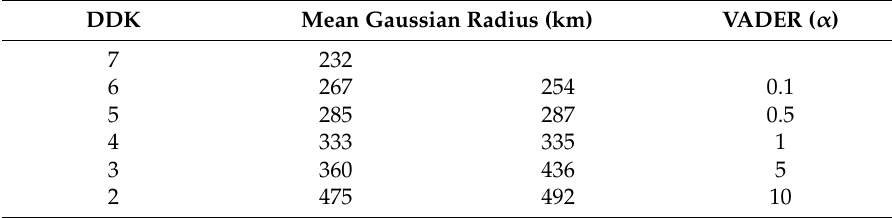
Table 1. Mean Gaussian radii estimated from filter kernels at 0, 30, and 60 degrees latitude over 124 months (2003-02 until 2013-12) for the ITSG-Grace2014-VADER filter. Radii for the DDK results are computed as simple mean from numbers given in [17] for 0, 30, and 60 degrees latitude. DDK Mean Gaussian Radius (km) VADER ( α ) 7 232 267 254 0.1